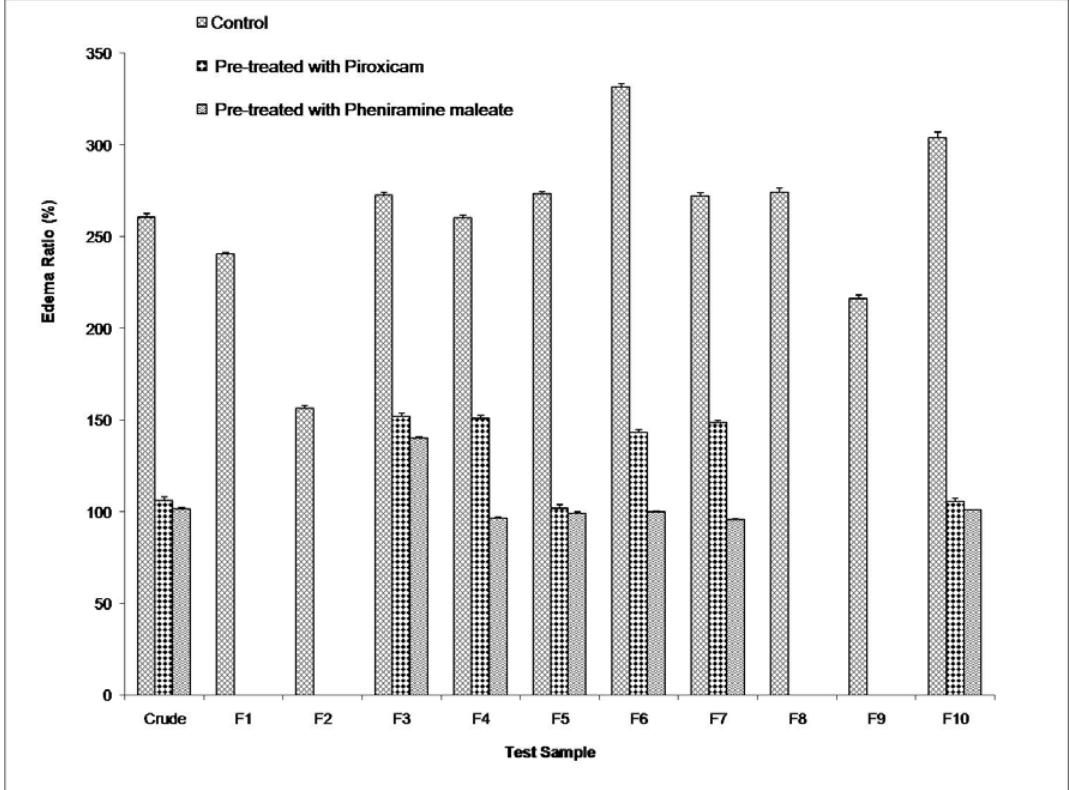
Figure 2. The extent of paw edema formation in male albino mice (20 ± 2 g) provoked by Stellaster equestris crude toxin (fractions F1 to F10) and the blocking of edematous activity by piroxicam and pheniramine